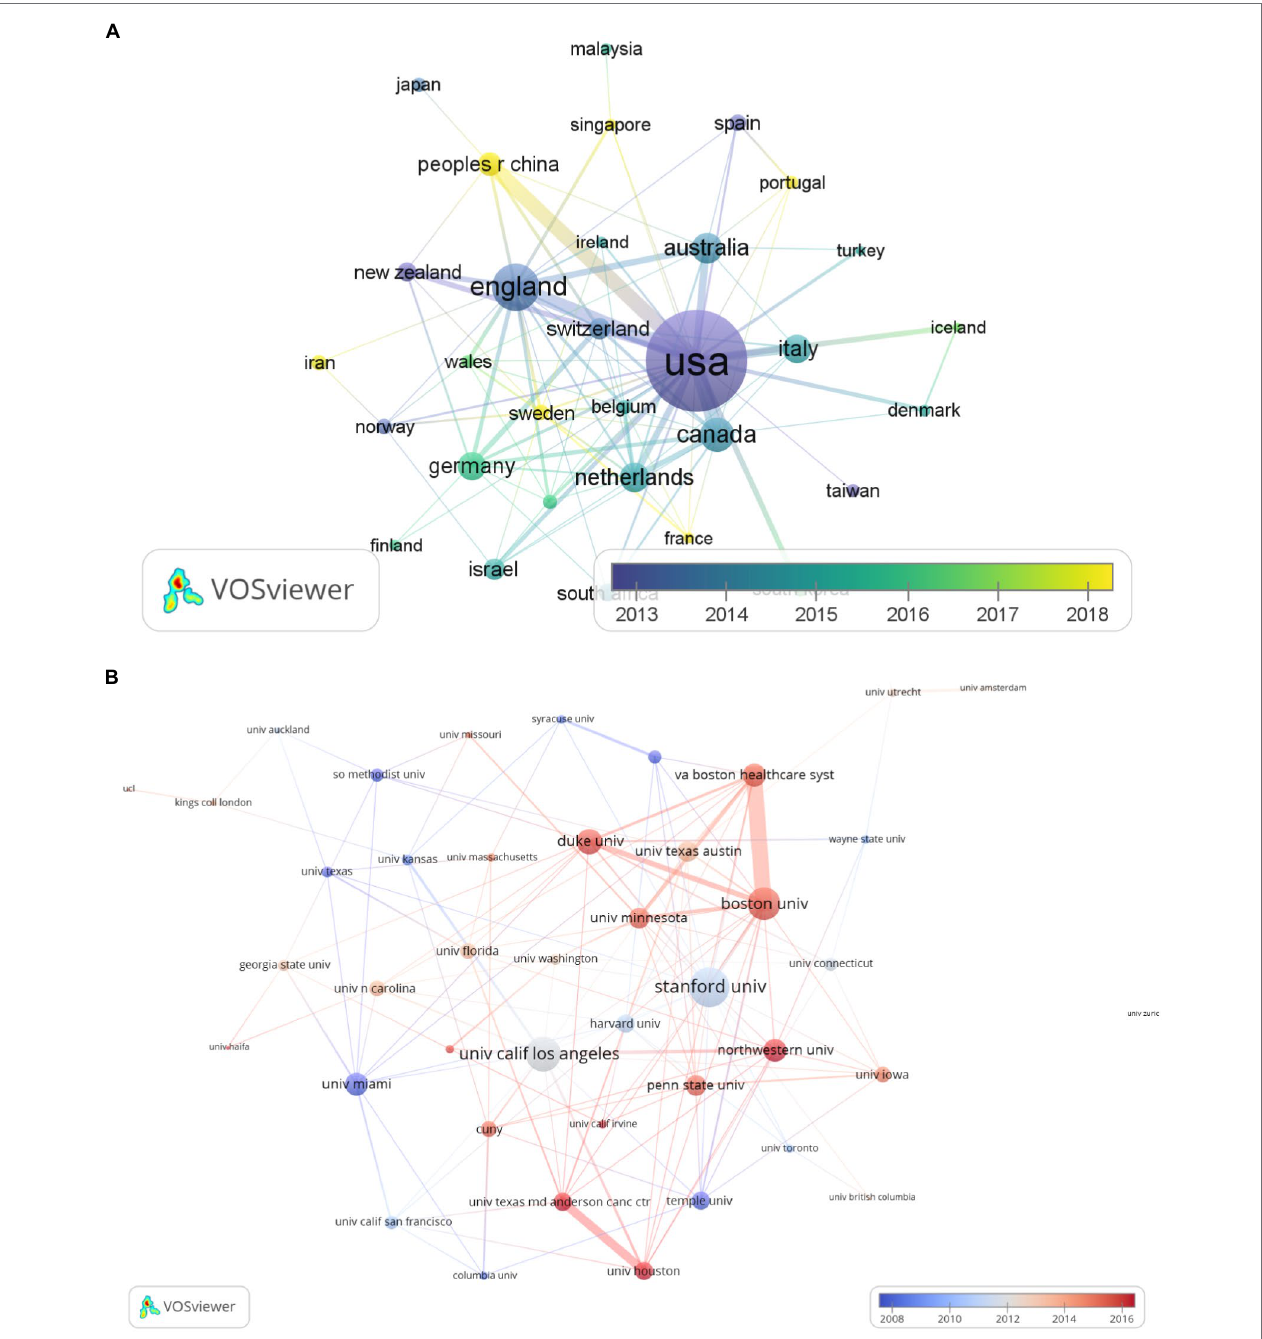
FIGURE 3 | (A) The cooperation network of the major countries/regions engaged in expressive writing studies. (B) The cooperation network between institutions (node label threshold ≥10). The size of nodes (i.e., institutions) denoted the published documents number, and the warm color suggested that the cooperation years were more recent than the ones illustrated by the cold colors. The width of the connecting lines represented the strength and frequency of the collaboration between two